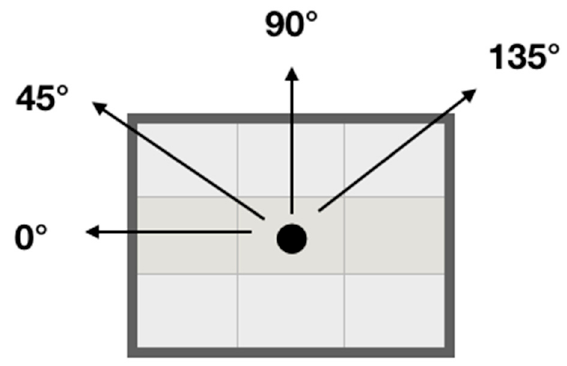
Figure 3. The gray-level co-occurrence matrices (GLCMs) features were extracted from four directions (0 ◦ , 45 ◦ , 90 ◦ , and 135 ◦ ) with distance of 1 pixel from the centered pixel ( (cid:8) (0°, 45°, 90°, and 135°) with distance of 1 pixel from the centered pixel ( ● ).